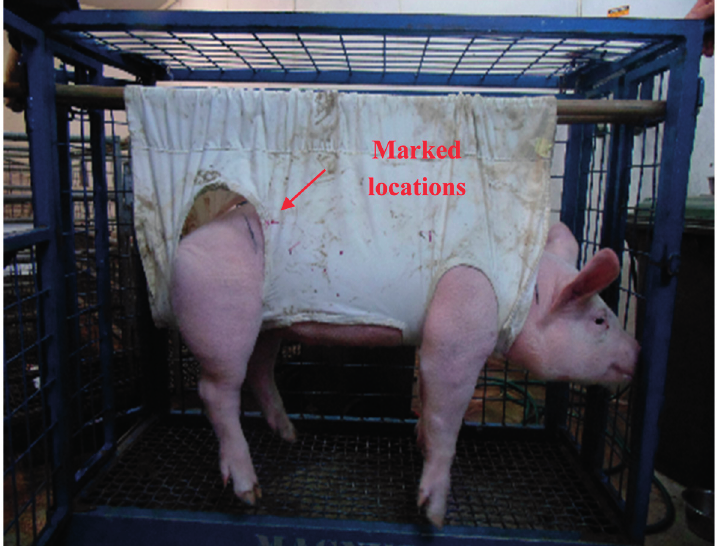
Figure 16. Location of the magnet is determined and marked on the pig.